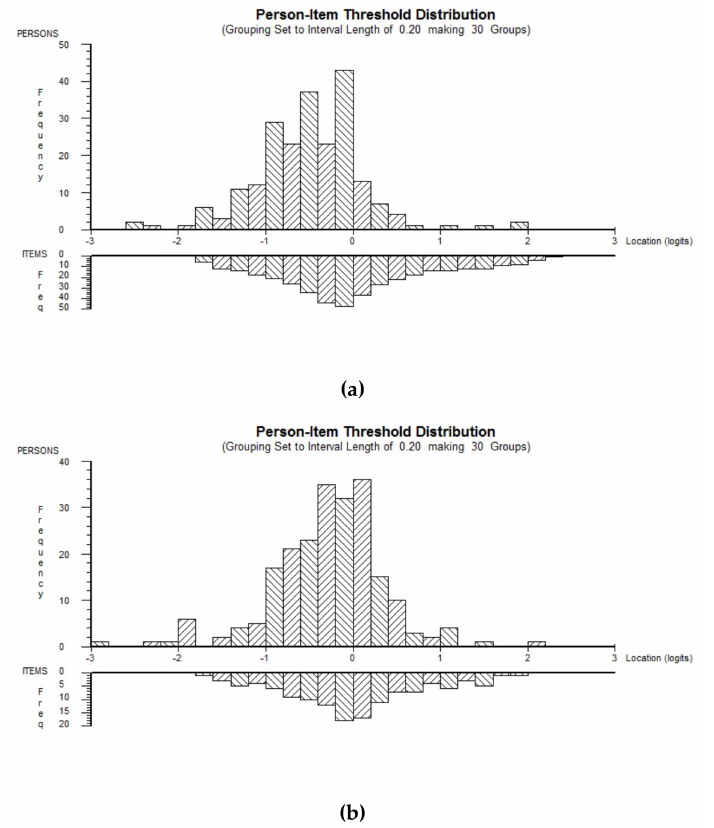
Figure 1. Person-Item Threshold Distribution: ( a ) WORQ and ( b )